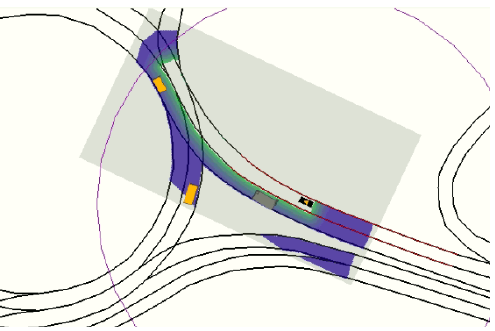
Figure 4. Lane invasion grid in the entrance of a double-lane roundabout.